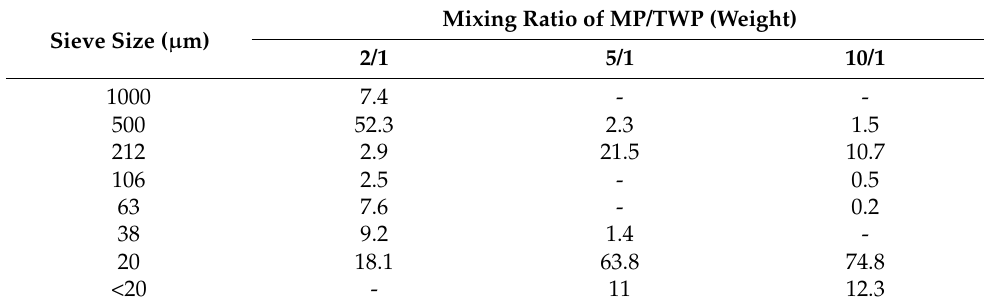
Table 1. Particle size distribution of mixture of initial particles (MP and TWP) and TRWPs made by different mixing ratios of the MP and TWP